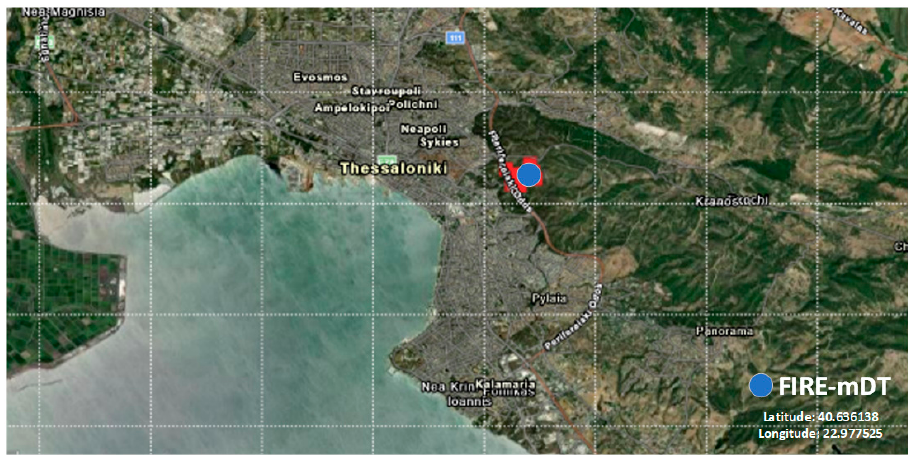
Figure 14. Fire data through VIIRS (red boxes) and fire-mDT detected location (blue circle) for the fire incident on 13 July 2021.